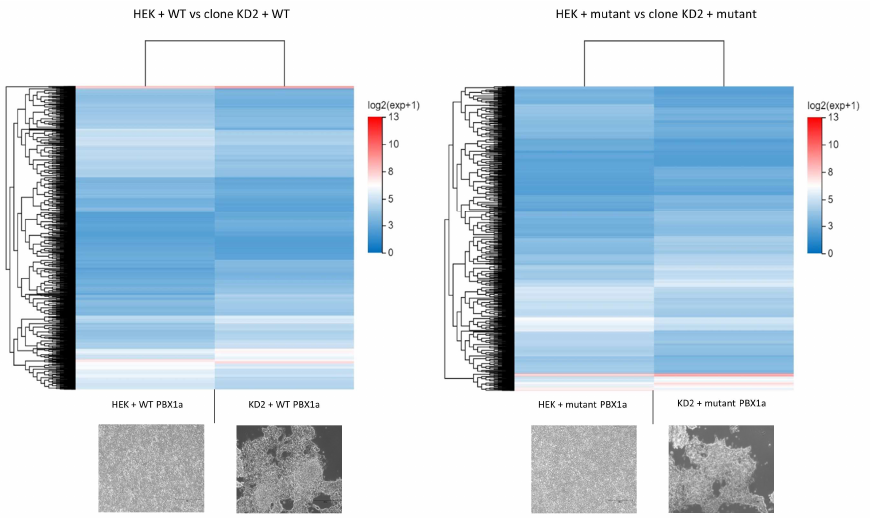
Figure 7. Heatmaps comparing the differential expression between WT HEK and PBX1 KD cells transfected with similar PBX1 plasmids. HEK + WT/mutant: WT HEK cells transfected with WT or mutant PBX1a plasmid. Clone KD2 + WT/mutant: KD2 cells transfected with WT or mutant PBX1a plasmid.